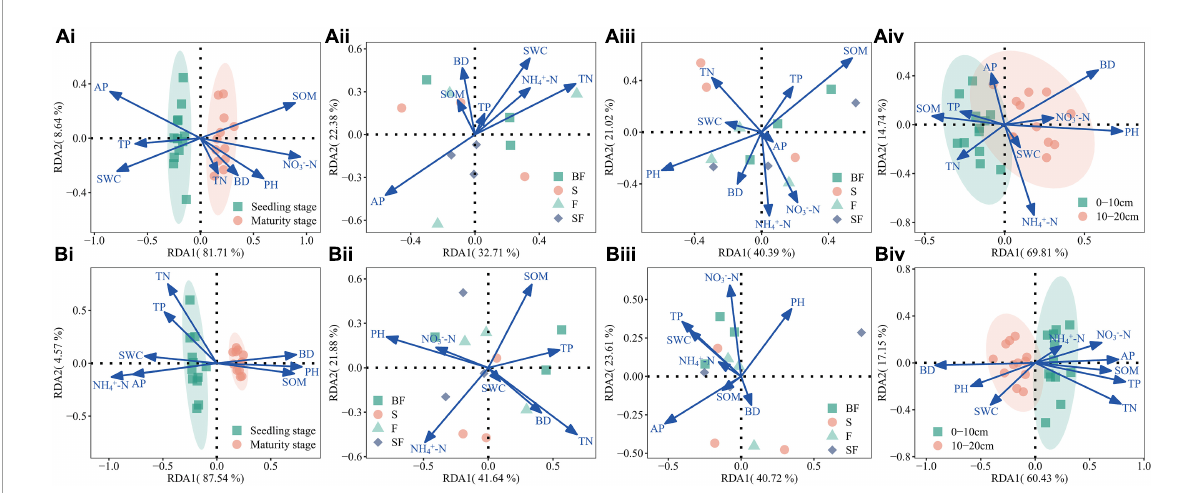
FIGURE6 (A) Illustrating associations between bacterial genera and environmental variables at 0–10 cm depth based on redundancy analysis (RDA). (Ai) growth stages, (Aii) different treatments at seedling stage, (Aiii) different treatments at maturity stage, (Aiv) different soil depths at seedling stage. (B) Illustrating associations between bacterial genera and environmental variables at 10–20 cm depth based on RDA. (Bi) growth stages, (Bii) different treatments at seedling stage, (Biii) different treatments at maturity stage, and (Biv) different soil depths at maturity stage.